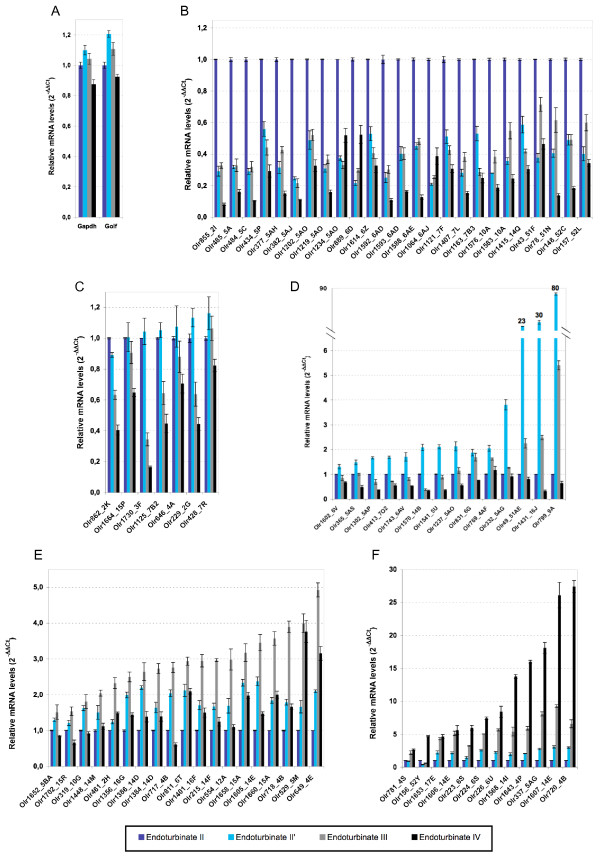
Differential expression of OR genes in the endoturbinates. We prepared mRNA from the four endoturbinates dissected from an adult rat. mRNA samples were used for RTqPCR (technical triplicates for each gene) for the same set of 77 OR genes. ΔΔCt values were expressed with respect to Hprt mRNA as internal reference and the control sample as external control as specified in [51]. Endoturbinate II', III and IV OR Ct values were normalized with respect to endoturbinate II OR Ct values, taken as a reference. The standard deviations are calculated from the triplicate values. Panel A is a control showing that Gapdh and Golf are expressed at similar levels in the four different endoturbinates. Panel B shows the Ct values for the OR genes that are more strongly expressed in endoturbinate II. Panel C shows OR genes with similar levels of expression in endoturbinates II and II'. In panel D, are shown OR genes more strongly expressed in endoturbinate II'; panel E presents OR genes more strongly expressed in endoturbinate III and, finally, panel F shows OR genes more strongly expressed in endoturbinate IV. On the x axis, OR gene family names follow gene names.